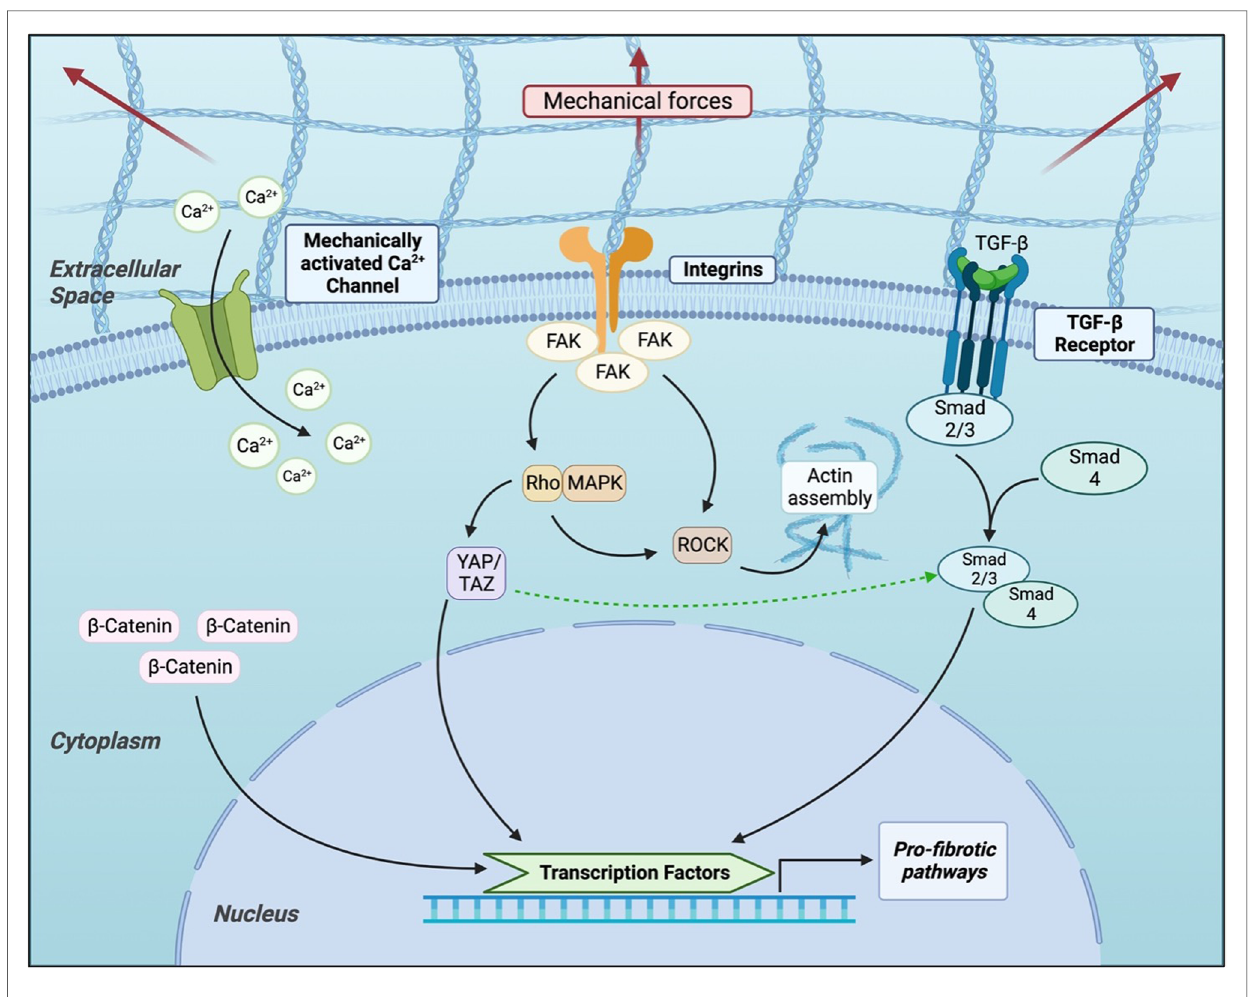
FIGURE 3 Current understanding of cellular signaling pathways related to mechanotransduction in fi